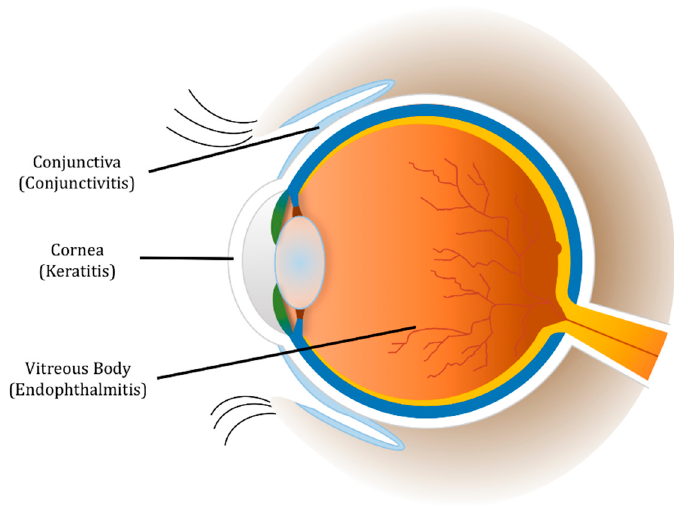
Figure 1. Diagram of the eye and sites of ocular inflammation. This figure illustrates areas of ocular infection and inflammation, such as conjunctivitis, keratitis, and endophthalmitis. The polymorphonuclear leukocyte (PMN) responses to the diseases shown in the diagram will be discussed. Note: Inflammation of the eye is also called uveitis, which will be discussed in its own section.